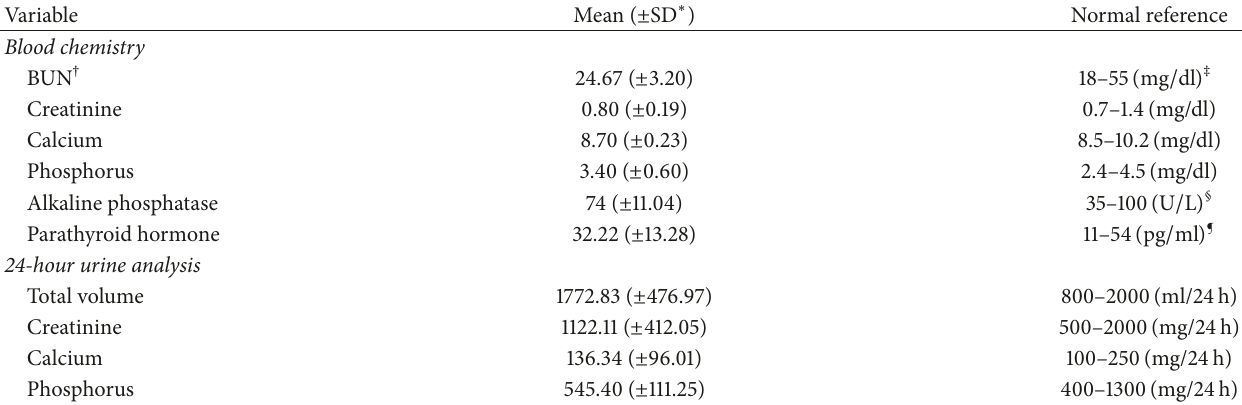
Table 2: Healthy participants’ blood and 24-hour urine samples studied for association between serum 25(OH)D and pulmonary volumes.